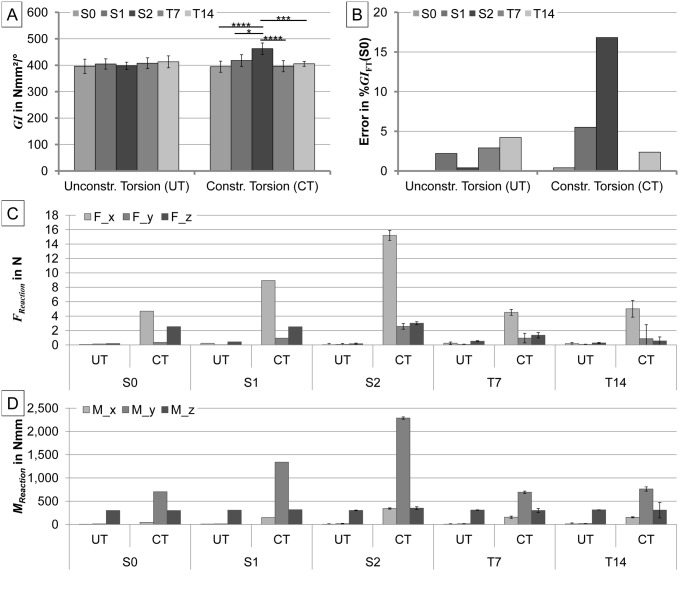
Results of the torsional testing.A) Torsional stiffness GI for the five different model designs S0, S1, S2, T7, and T14, under unconstrained (UT-left) and constrained (CT-right) axial torsion. B) The respective errors of the means in relation to the reference mean value (i.e. stiffness of S0 under unconstrained torsion). C) Reaction forces F at the gimbal in axial direction (z) and the secondary directions (x and y). D) Reaction moments M at the gimbal in axial direction (z) and the secondary directions (x and y). *p<0.05, ***p<0.001, ****p<0.0001.